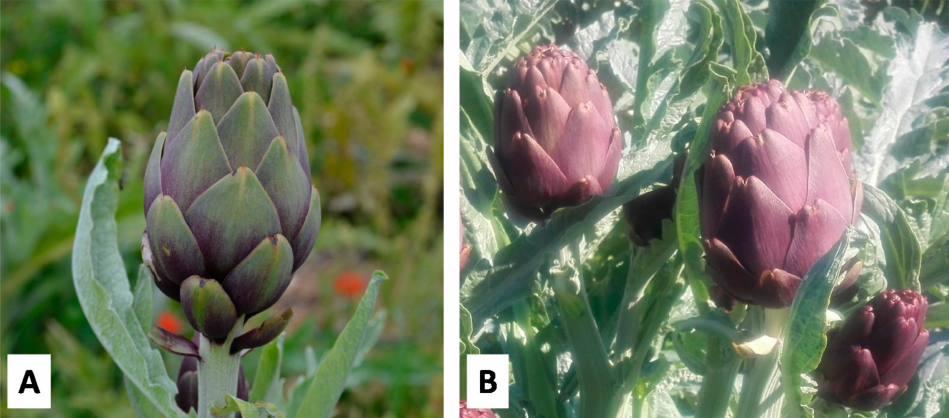
Figure 1. Genotypes of globe artichoke used in the study: Brindisino ( A ); Capriccio ( B ). The experimental treatments were arranged according to a split-plot design with three replications, where SMSs were set in the main plots (7.80 m × 10.80 m) and the genotypes in the sub-plots (3.90 m × 10.80